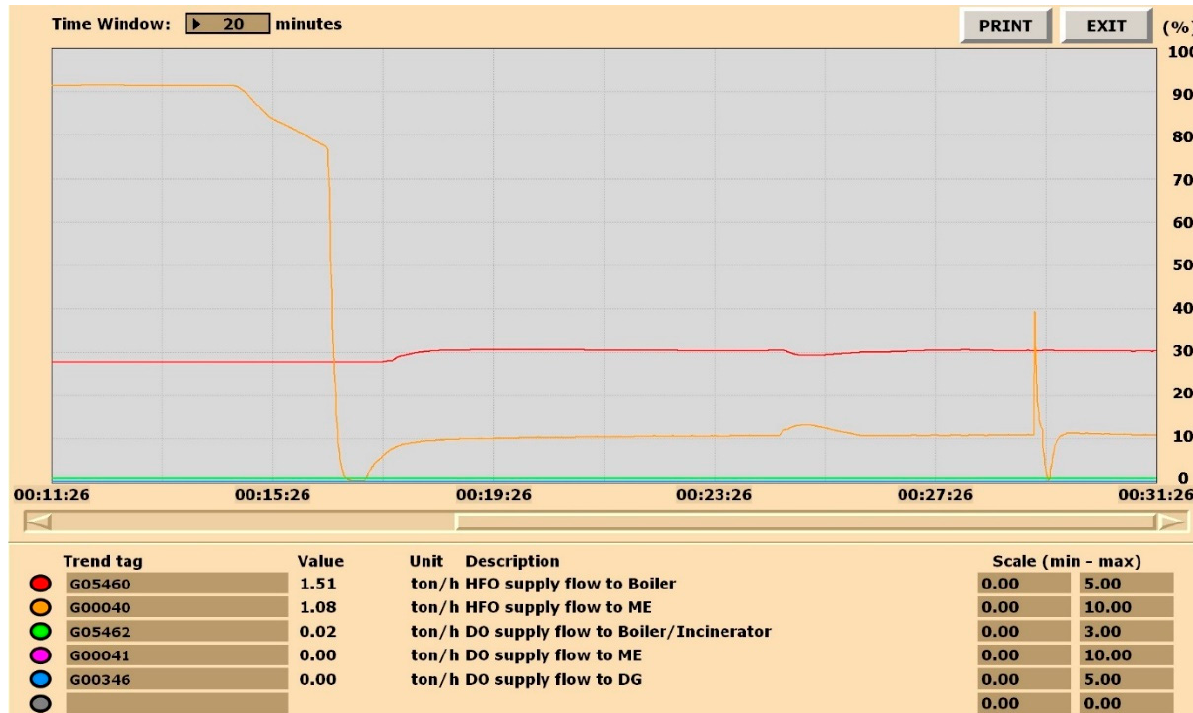
Figure 6. Fuel flows for mode 2.2 (container ship).